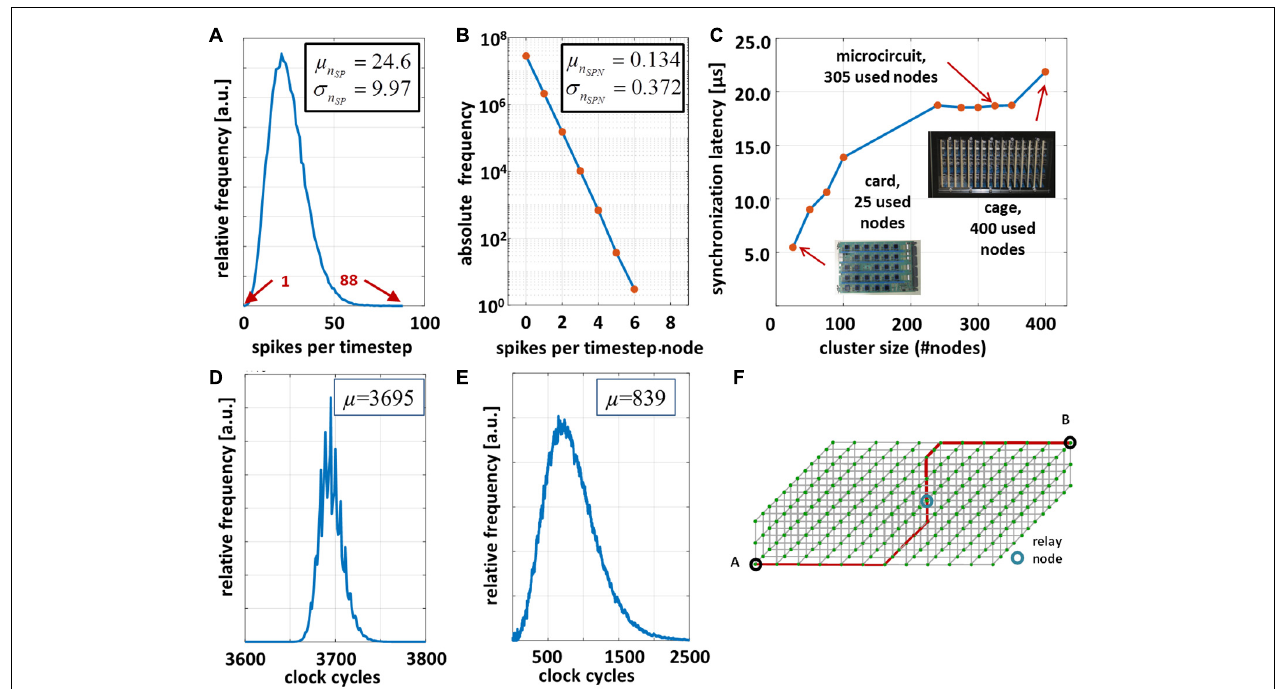
FIGURE 6 | Performance evaluation of the microcircuit cortical model on the INC-3000 system for t BRT = 15 min. and simulation time step (cid:49) t = 100 µ s. (A) Distribution of the experimentally observed spike density [measured in (spikes/timestep)]. (B) Distribution of generated spikes per node per time step. (C) Synchronization latency dependent on the cluster size of active nodes. (D) Distribution of elapsed clock cycles between logical time steps. (E) Distribution of elapsed clock cycles to unroll the node-local connection structure via the RTR-unit. (F) 3D-node mesh. The nodes A and B are separated with maximum